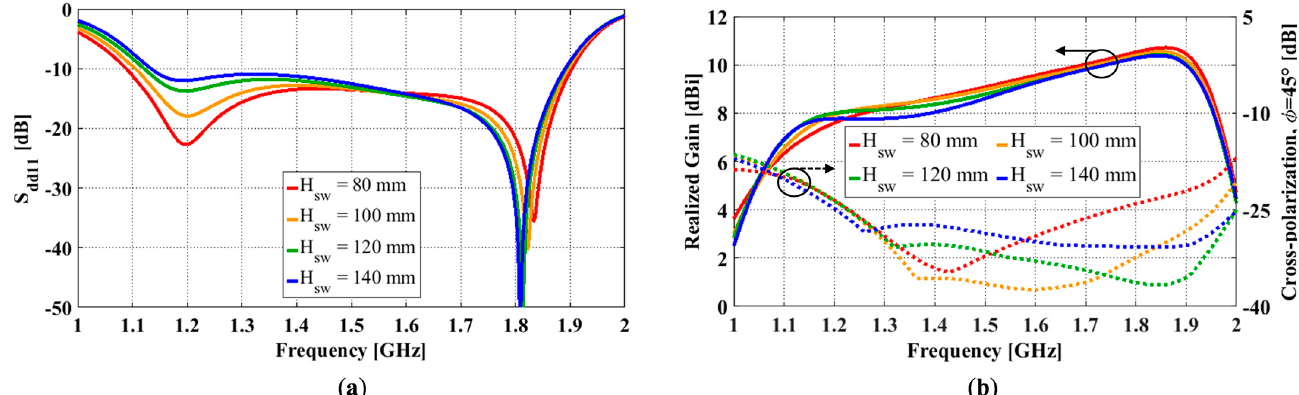
Figure 6. OCROP with different sidewall heights: ( a ) Differential reflection coefficient; ( b ) Realized gain (solid, left y-axis) and peak cross-polarization ratio (dotted, right y-axis). The effect of varying the sidewall height on the gain and the diagonal plane ( ϕ = 45°) cross-polarization ratio is shown in Figure 6b. The gain at the low end of the impedance bandwidth ( 𝑓 (cid:2869) ) is around 6.5 dBi and increases to a peak of 10.7 dBi at the upper frequency ( 𝑓 (cid:2870) ). There are small variations in gains in relation to different sidewall heights, and the trend is relatively consistent between the simulation results. As the sidewall height in- creases from 70 mm to 140 mm, the cross-polarization bandwidth significantly increases from 25.8% to 49.2%. Varying the sidewall height had little effect on the cross-polarization at the lower end of the operating band but significantly affected the cross-polarization in the mid and upper sections of the operating band. The minimum cross-polarization at 𝑓 (cid:2869) occurs when the sidewall height reaches 100 mm. Beyond this height, the cross-polariza- tion ratio rises in the mid-section of the operating band. The minimum cross-polarization at 𝑓 (cid:2870) occurs when the sidewall height reaches 120 mm. The bandwidth of operation is summarized in Table 1. As the sidewall height in- creases, impedance bandwidth (for S dd11 ≤ − 10 dB) decreases while cross-polarization bandwidth (for X-pol ≤ − 25 dB) increases. In column 4, we present the combined band- width, where we took the minimum and maximum frequencies that met both require- ments. In all cases, the lower frequency bound, 𝑓 (cid:2869) , is limited by the cross-polarization ratio. The upper frequency bound, 𝑓 (cid:2870) , is limited by the impedance bandwidth for H sw ≤ 90 mm and the cross-polarization bandwidth for H sw ≥ 100 mm. Once the sidewall height reaches 90 mm, there is very little change in the overall operating bandwidth (42.7 ± 0.7%). Table 1. OCROP antenna bandwidths (BWs) and gain as a function of sidewall height. The aperture field distribution for the antenna, with g = 11 mm and H sw = 80 mm, at 1.5 GHz on a fictitious square surface with a length of 4 λ , located 1 λ above the aperture, as shown in Figure 7 exhibits a uniform characteristic, with large peak electric field magnitudes immediately above the antenna. As observed from the figure, the aperture field extends well beyond the physical aperture of the antenna, which causes the gain enhancement and aperture efficiency to be greater than